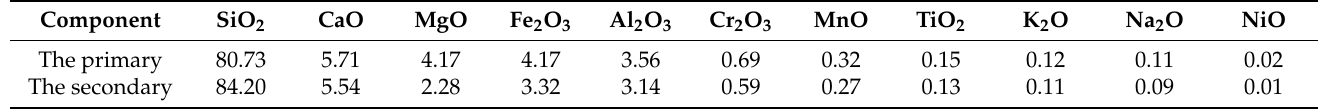
Table 2. XRF comparative analysis of the two stages acid leaching